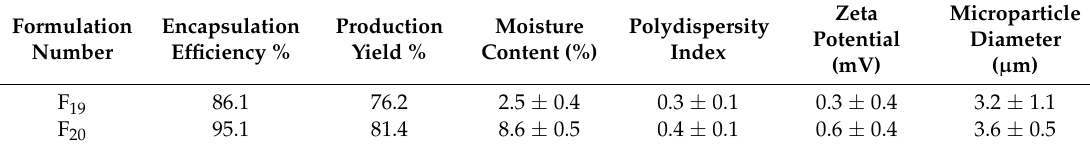
Table 6. Characteristics of microparticles obtained from aqueous EC dispersions (F 19 and F 20 ).